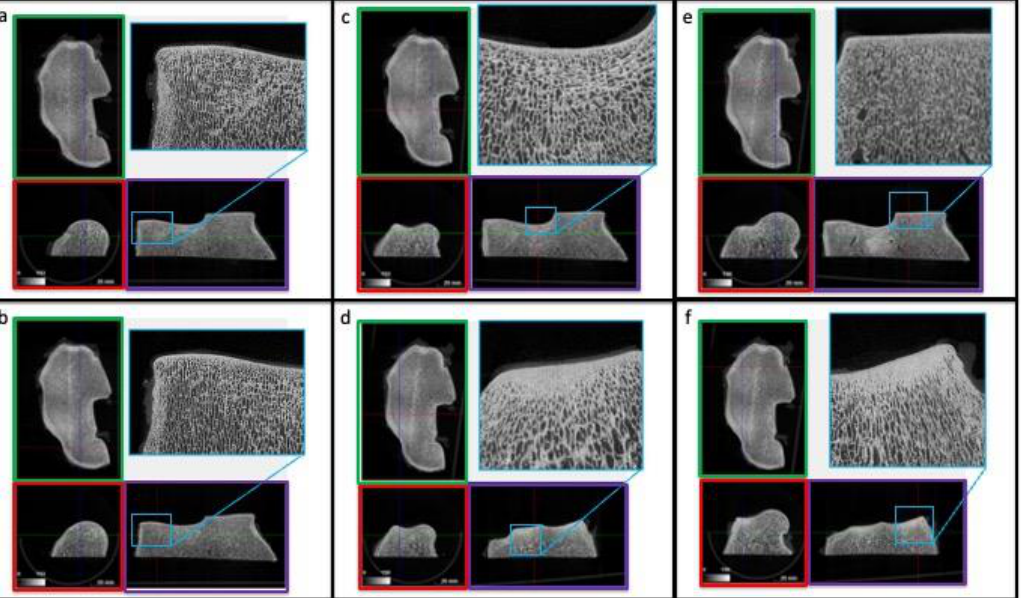
Figure 5. Qualitative µCT analysis of the distal radius (radio-carpal joint). Panels ( a – f ) represent different regions of the radial epiphysis. Moderate bone densification is limited over the subchondral bone regions, at the level of the dorsal aspect of the radial facet of the radius ( d , f ). The sagittal (red box), coronal (green box) and transverse planes (violet box) of the distal radial epiphysis are shown. The plane of cuts of the µCT are indicated within the corresponding color borders. Table 3. Quantitative µCT data of selected volume of interest (VOI) from the antebrachio-carpal joint, taken at the level of the distal radius, as shown in the corresponding illustration. Parameters measured included bone volume fraction (BV/TV), trabecular thickness (Tb.Th), trabecular spacing (Tb.Sp) and number (Tb.N), fragmentation index (Tb.Pf), structure model index (SMI), degree of anisotropy (Da) and cartilage thickness (C.Th). The C.Th. has been reported as a mean value, and with the minimal and maximal value. Trabecular Bone Cartilage VOI BV/TV Tb.Th Tb.SP Tb.N Tb.Pf SMI C.th % μm